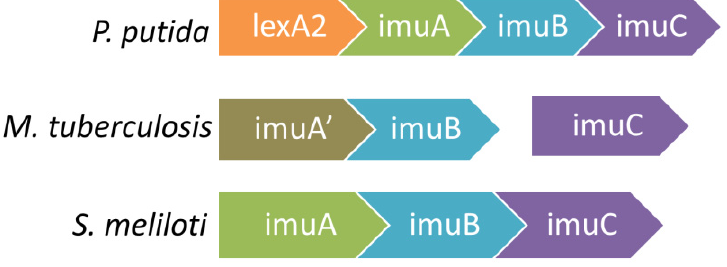
Figure 1. Some characteristic configurations of the imuABC mutagenesis cassette are shown below. The plethora of imuABC operons has been characterized extensively [183,190,195]. While P. putida and S. meliloti have imuA , imuB , and imuC together as one operon, M. tuberculosis contains imuC separated from imuA and imuB , as well as imuA ' instead of imuA